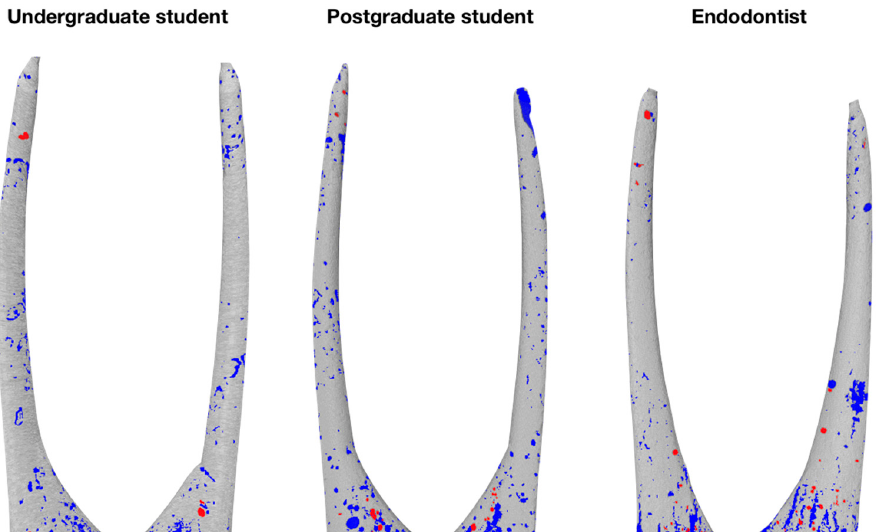
Figure 1. Three-dimensional reconstructions of the single cone root canal fillings of different experimental groups, demonstrating distribution of open (blue) and closed (red) pores.